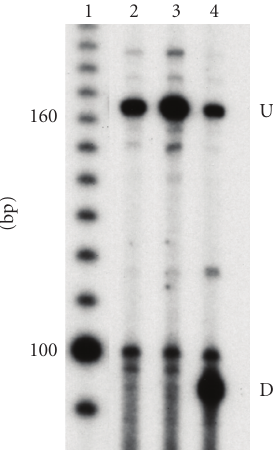
Figure 3: Binding of TFOs to genomic DNA targets. 2 μ M of TFO, either TFO RNA-C2 (lanes 2 and 3) or TFO DNA-C2 (lane 4) were incubated with genomic DNA purified from HT1080 cells and mock irradiated (lane 2) or irradiated with 0.2 J/cm 2 UVA (lanes 3 and 4) and analyzed by single-strand ligation PCR to assay for undamaged (U) and site-specifically damaged (D) DNA. Lane 1 is a 10 base pair DNA